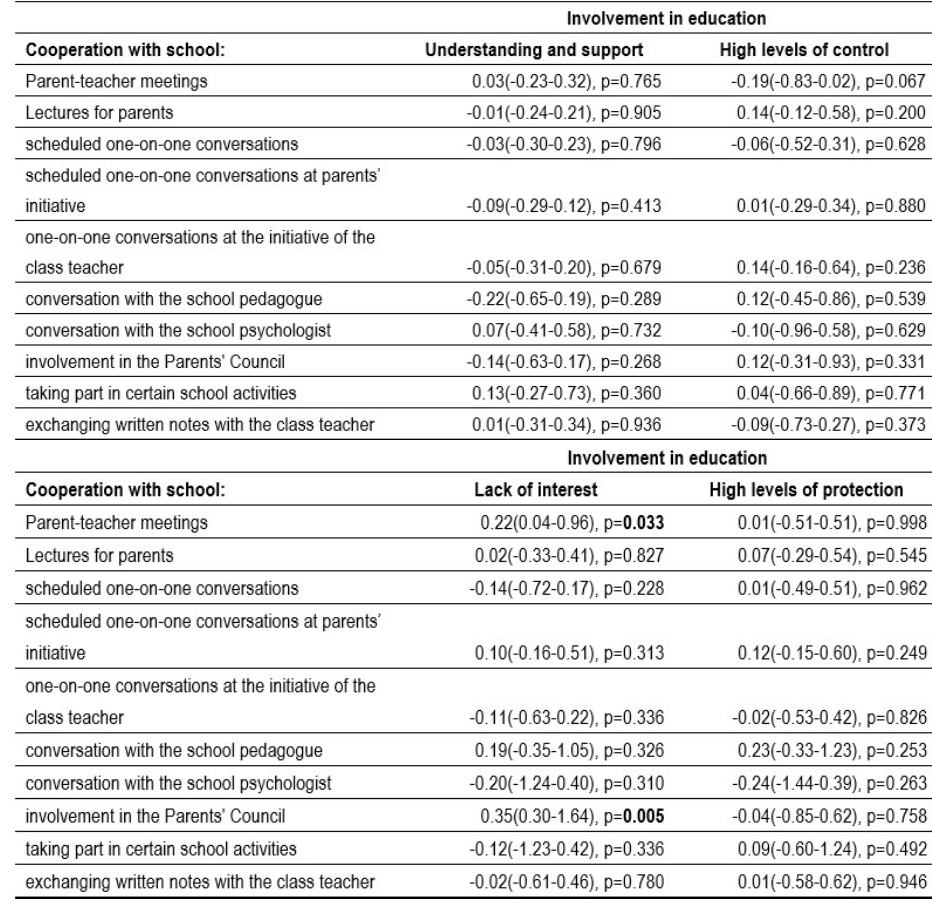
Prediction of the type of fathers’ involvement in child’s education based on their cooperation with